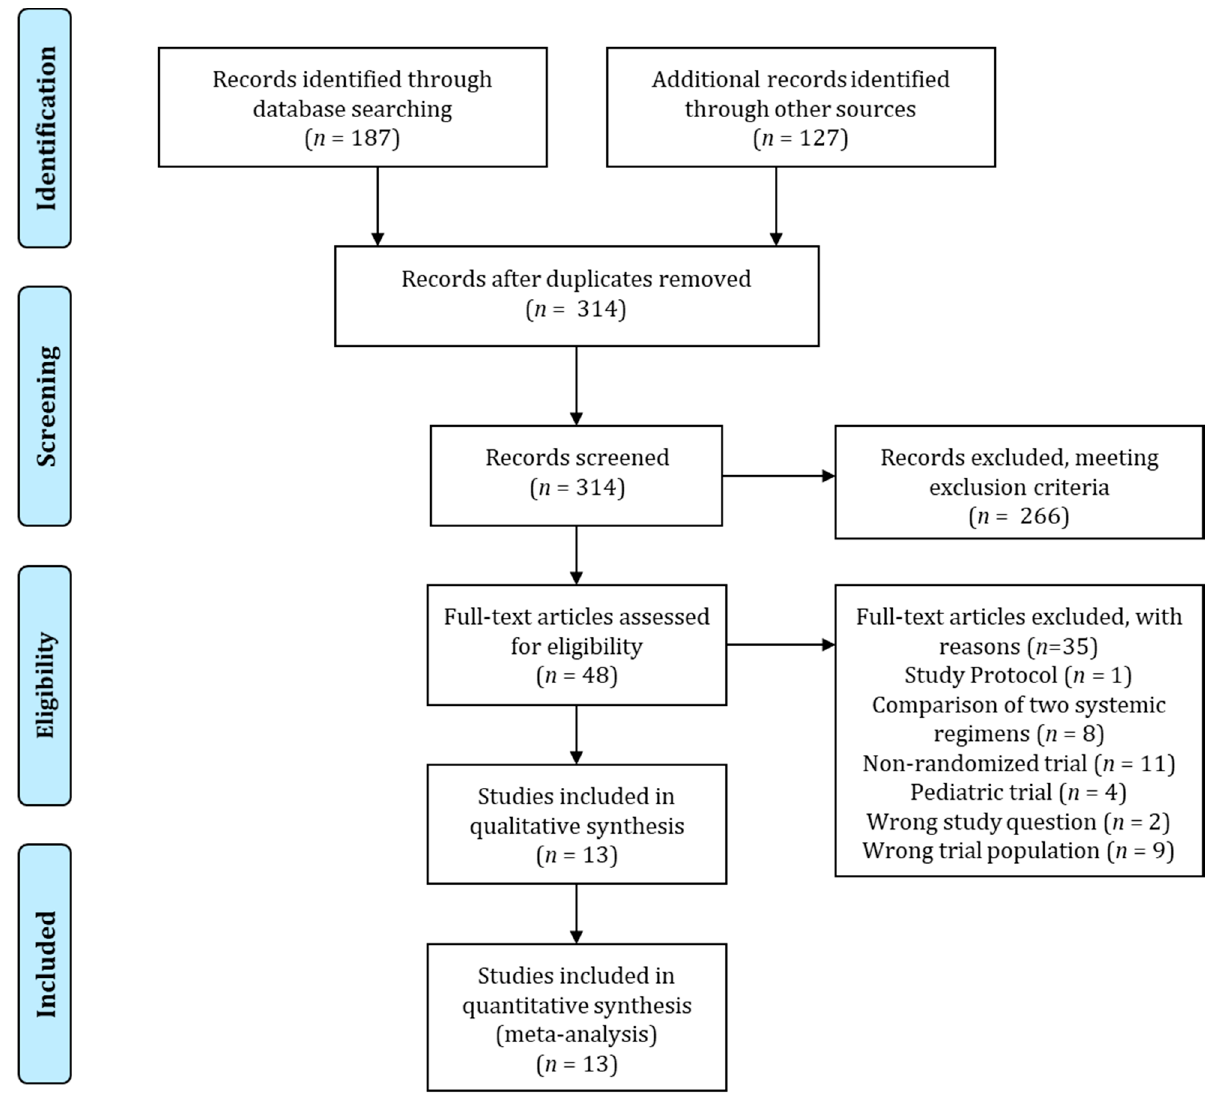
Figure 1. The PRISMA flow chart of the literature search.